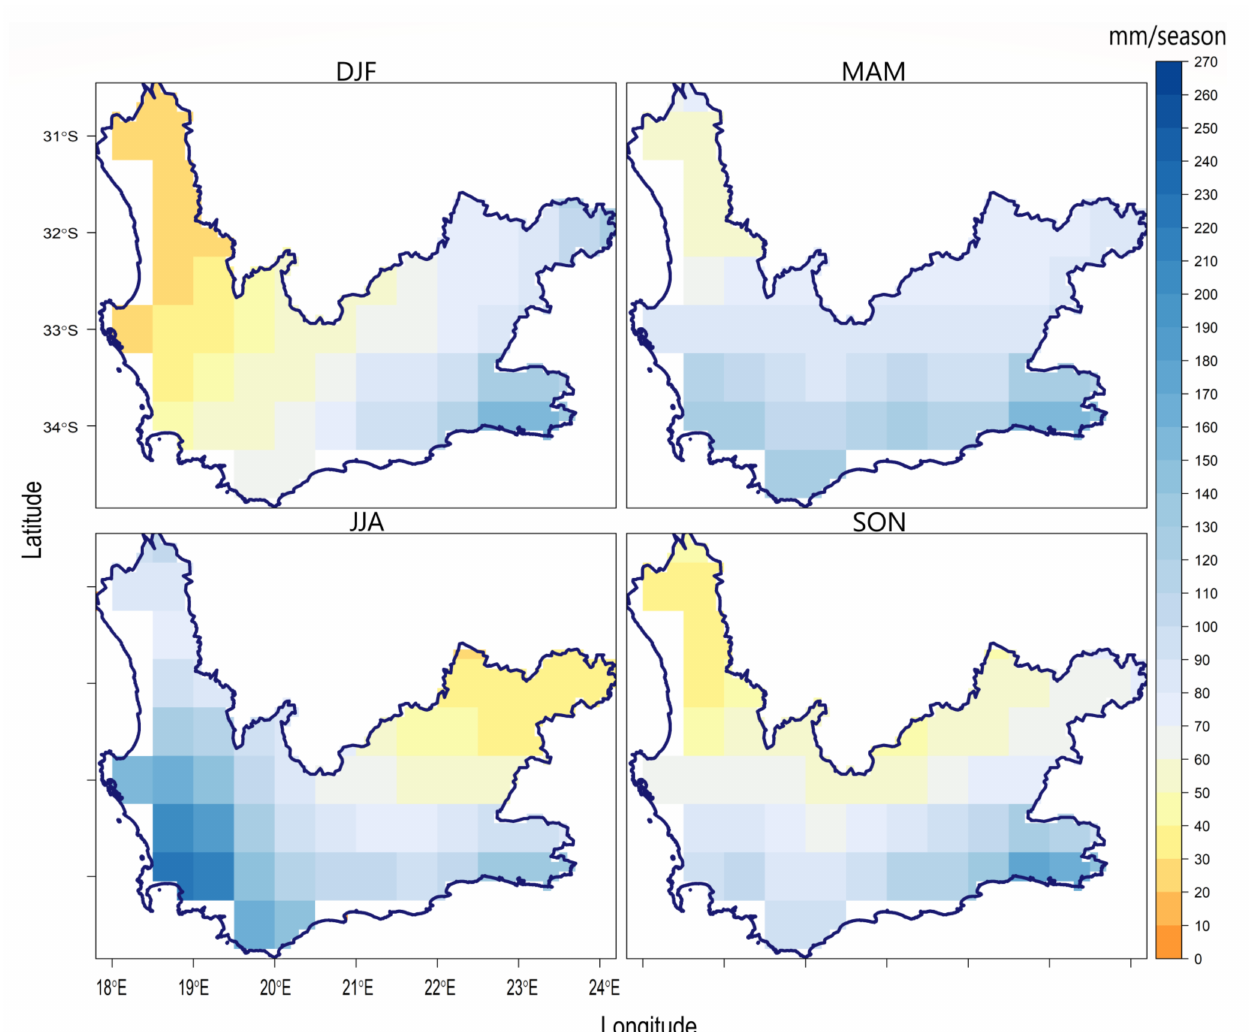
Figure 2. Seasonal rainfall climatology from CPC dataset for the 1979–2020